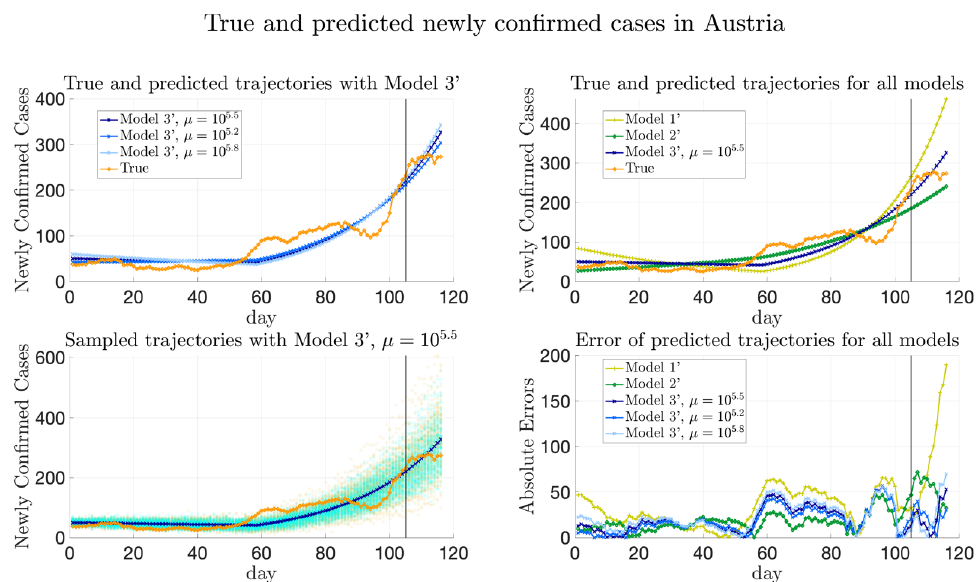
Figure 13. True and fitted trajectories in Austria. The remarks for the lines and scatter plots are the same as those in Fig. 8. The vertical lines show the threshold T th = 102 of training-testing split of COVID-19 data in Europe. For Model 3’, µ = 10 5.2 , 10 5.5 , and 10 5.8 are chosen. As shown in Fig. 17 and Supplementary Fig. S6, the validation errors are minimized at µ = 10 5.5 , and µ = 10 5.2 and 10 5.8 are obtained by perturbing the minimizer µ = 10 5.5 . µ = 10 5.2 , 10 5.5 , and 10 5.8 are marked by yellow pentagrams, blue squares, and green diamonds respectively in Fig. 17 and Supplementary Fig. S6.